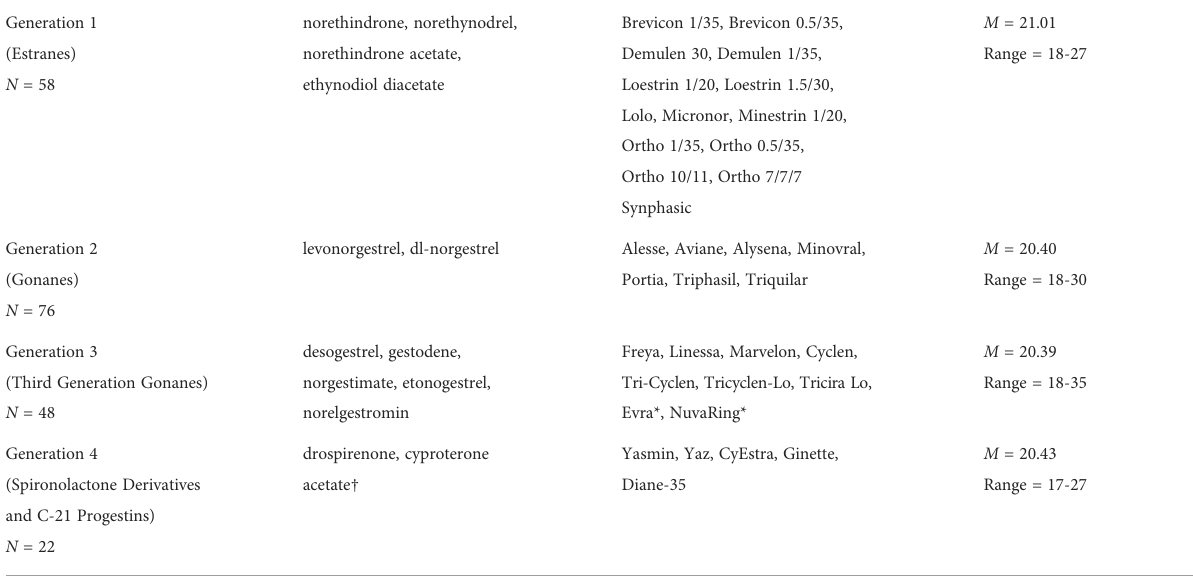
TABLE 2 The four families of contraceptive progestins and speci fi c brand names represented in the dataset ( N =